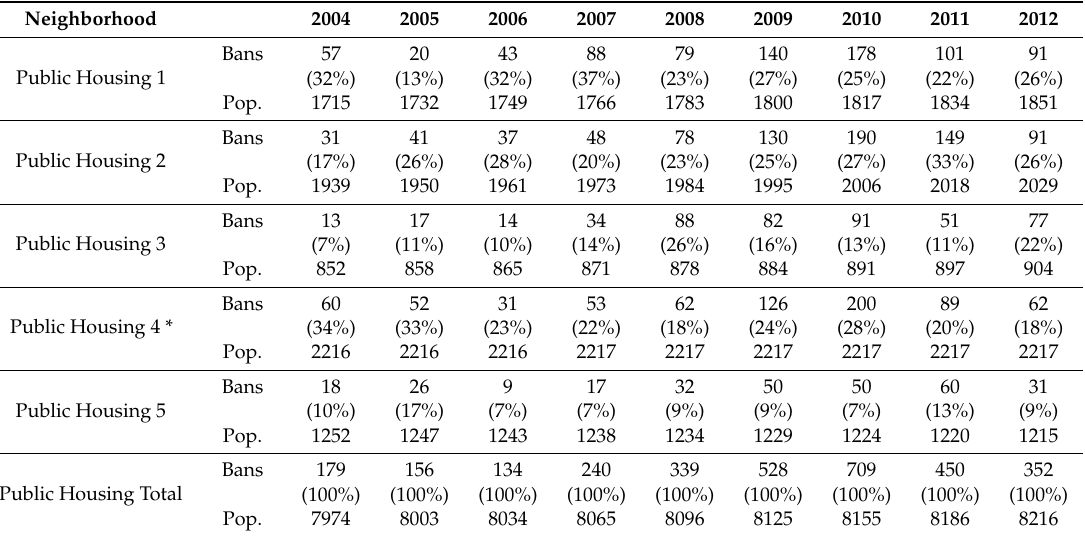
Table 1. Bans and population by public housing neighborhood by